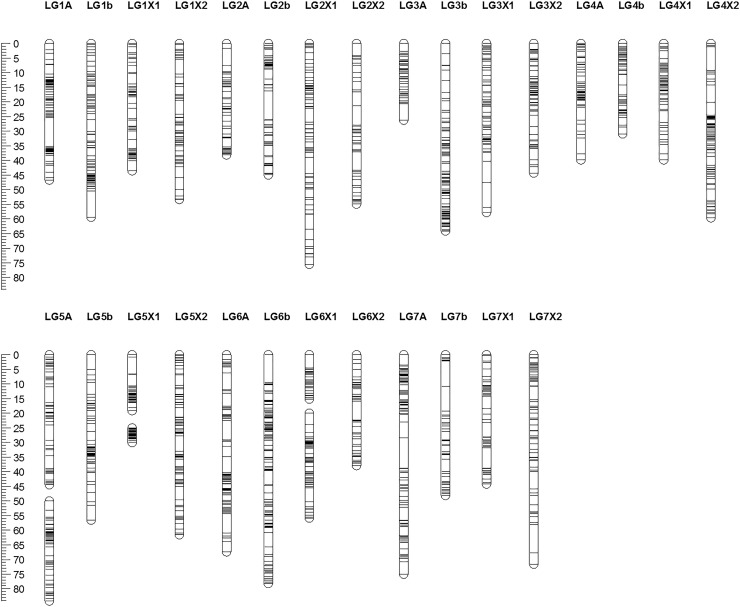
The ‘Sonata’ and ‘Babette’ F1 linkage map containing 3,550 markers at 1,474 loci in 31 linkage groups representing the 28 haploid chromosomes of the F.×ananassa genome. The linkage map spans a total genetic distance of 1498.2 cM and a total physical distance of 769.9 Mbp, estimated from the physical positions of the distal- and proximal-most markers on the diploid F. vesca v4.0 genome sequence. All linkage groups have been assigned to one of the four F. ×ananassa homeologous subgenomes (i.e. A, b, X1 or X2) of the linkage map of Sargent et al [26] through identification of common markers in the two studies.